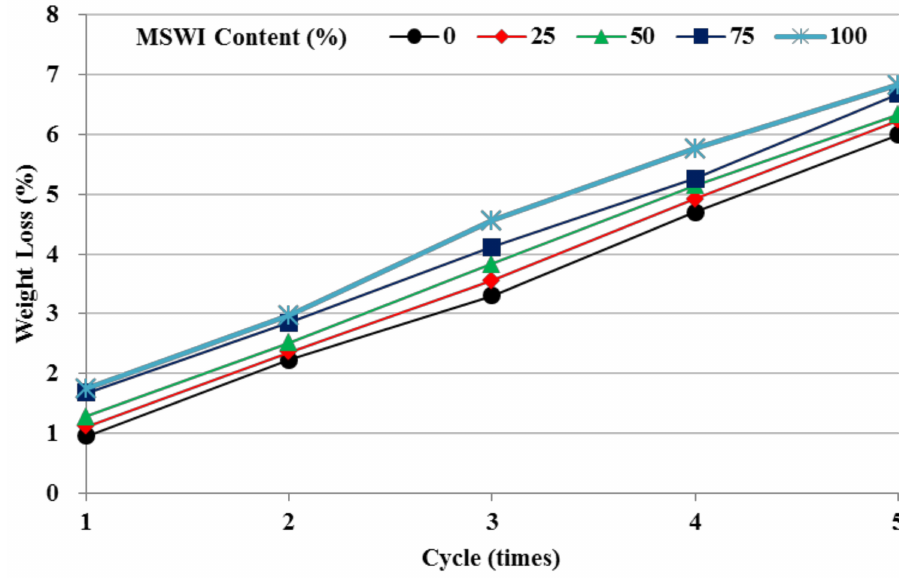
Figure 7. Effect of MSWI content on sulfate attack weight